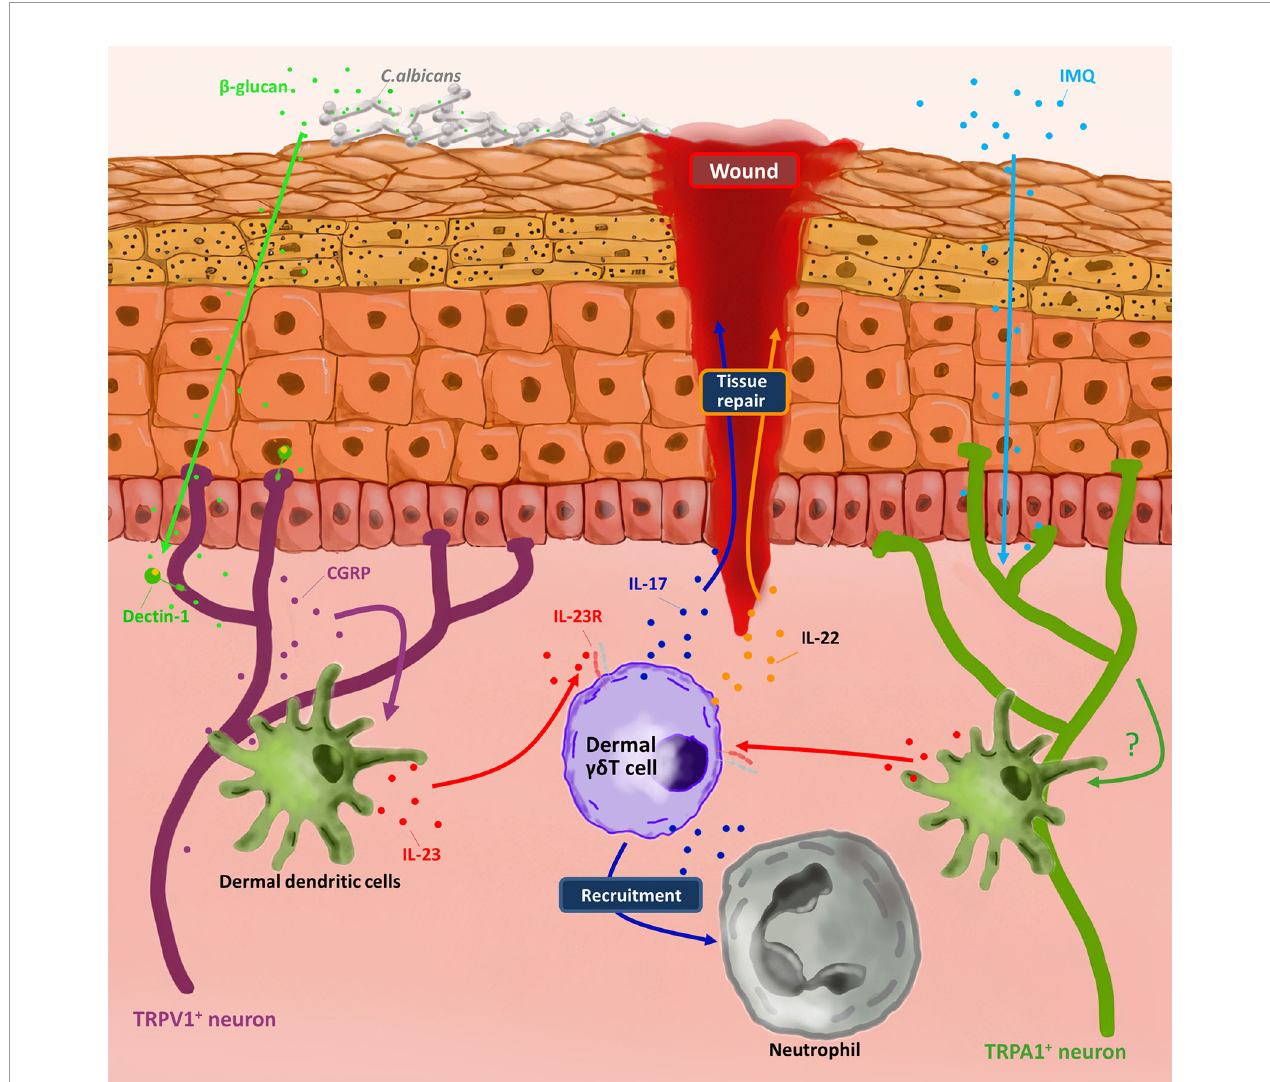
FIGURE 2 | Dermal gd T cells involved in nociceptors-induced skin protection. By sensing molecules such as C. albicans -derived soluble b -glucan and imiquimod (IMQ) respectively, TRPV1+ neuron and TRPA1+ neuron active dermal dendritic cells produce IL-23. In response to IL-23, dermal gd T cells produce IL-17 and IL-22 to repair the wound and recruit neutrophils for pathogen